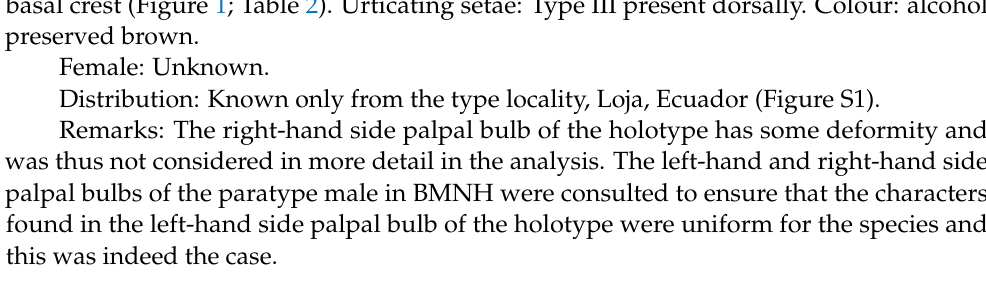
Table 1. Thrixopelma nadineae sp. nov. holotype male (ZMH-0000888), podomere lengths.